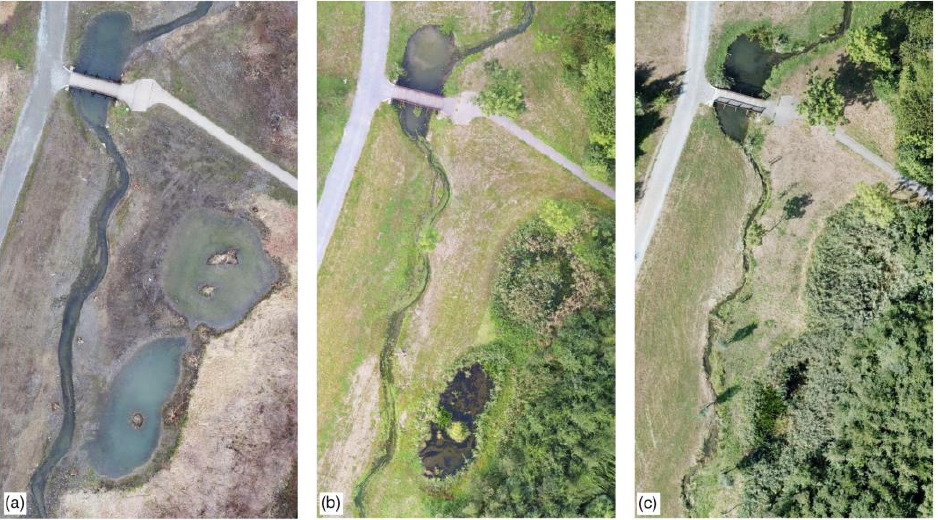
Figure 8. Progress of eutrophication and overgrowth in the newly built ponds at HOS. ( a ) April 2016, ( b ) June 2017, ( c ) August 2018. ( b ) June 2017, ( c ) August